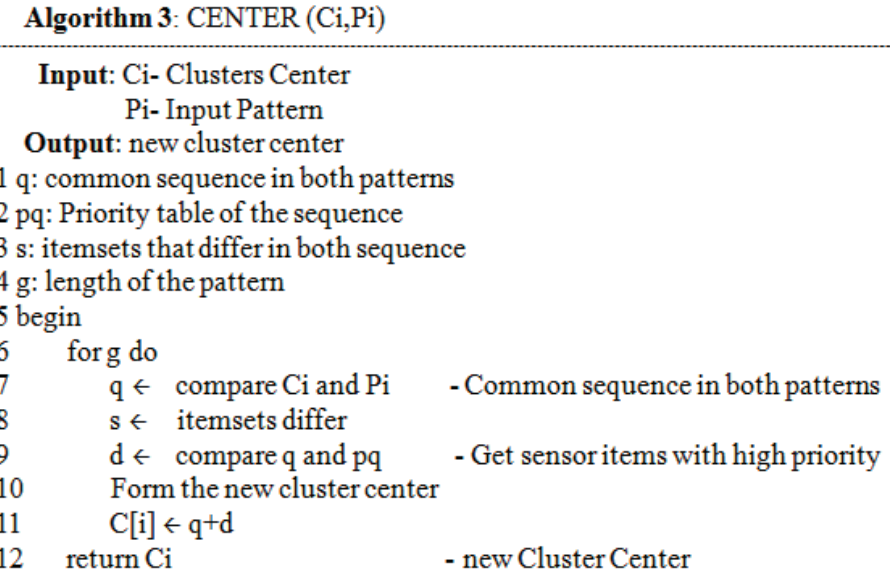
Figure 7. Process of recomputing new center [1].